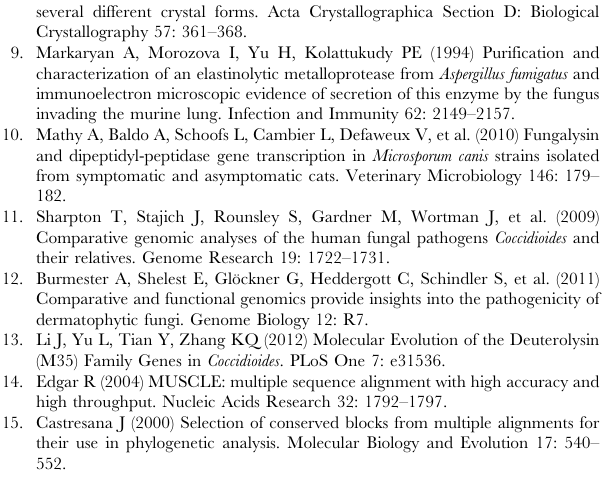
Figure S1 Amino acid sequences alignment for 62 M35 family genes with MUSCLE 3.5. (DOC) Figure S2 Amino acid sequences alignment for 38 M36 family genes with MUSCLE 3.5. (DOC) Figure S3 Amino acid sequences alignment of 105 M35 genes with MUSCLE 3.5. (DOC) Figure S4 The Bayesian tree based on 105 M35 family genes by using MrBayes 3.1.2. (DOCX) Figure S5 Amino acid sequences alignment of 58 M36 genes with MUSCLE 3.5. (DOC) Figure S6 The Bayesian tree based on 58 M36 family genes by using MrBayes 3.1.2. (DOCX) Figure S7 Species tree of Onygenales fungi used for gene duplication and loss analyses in the study. (DOCX) Figure S8 Species tree of Eurotiales fungi used for gene duplication and loss analyses in the study. Table S1 The physic-chemical properties of the positive selected amino acids identified in this